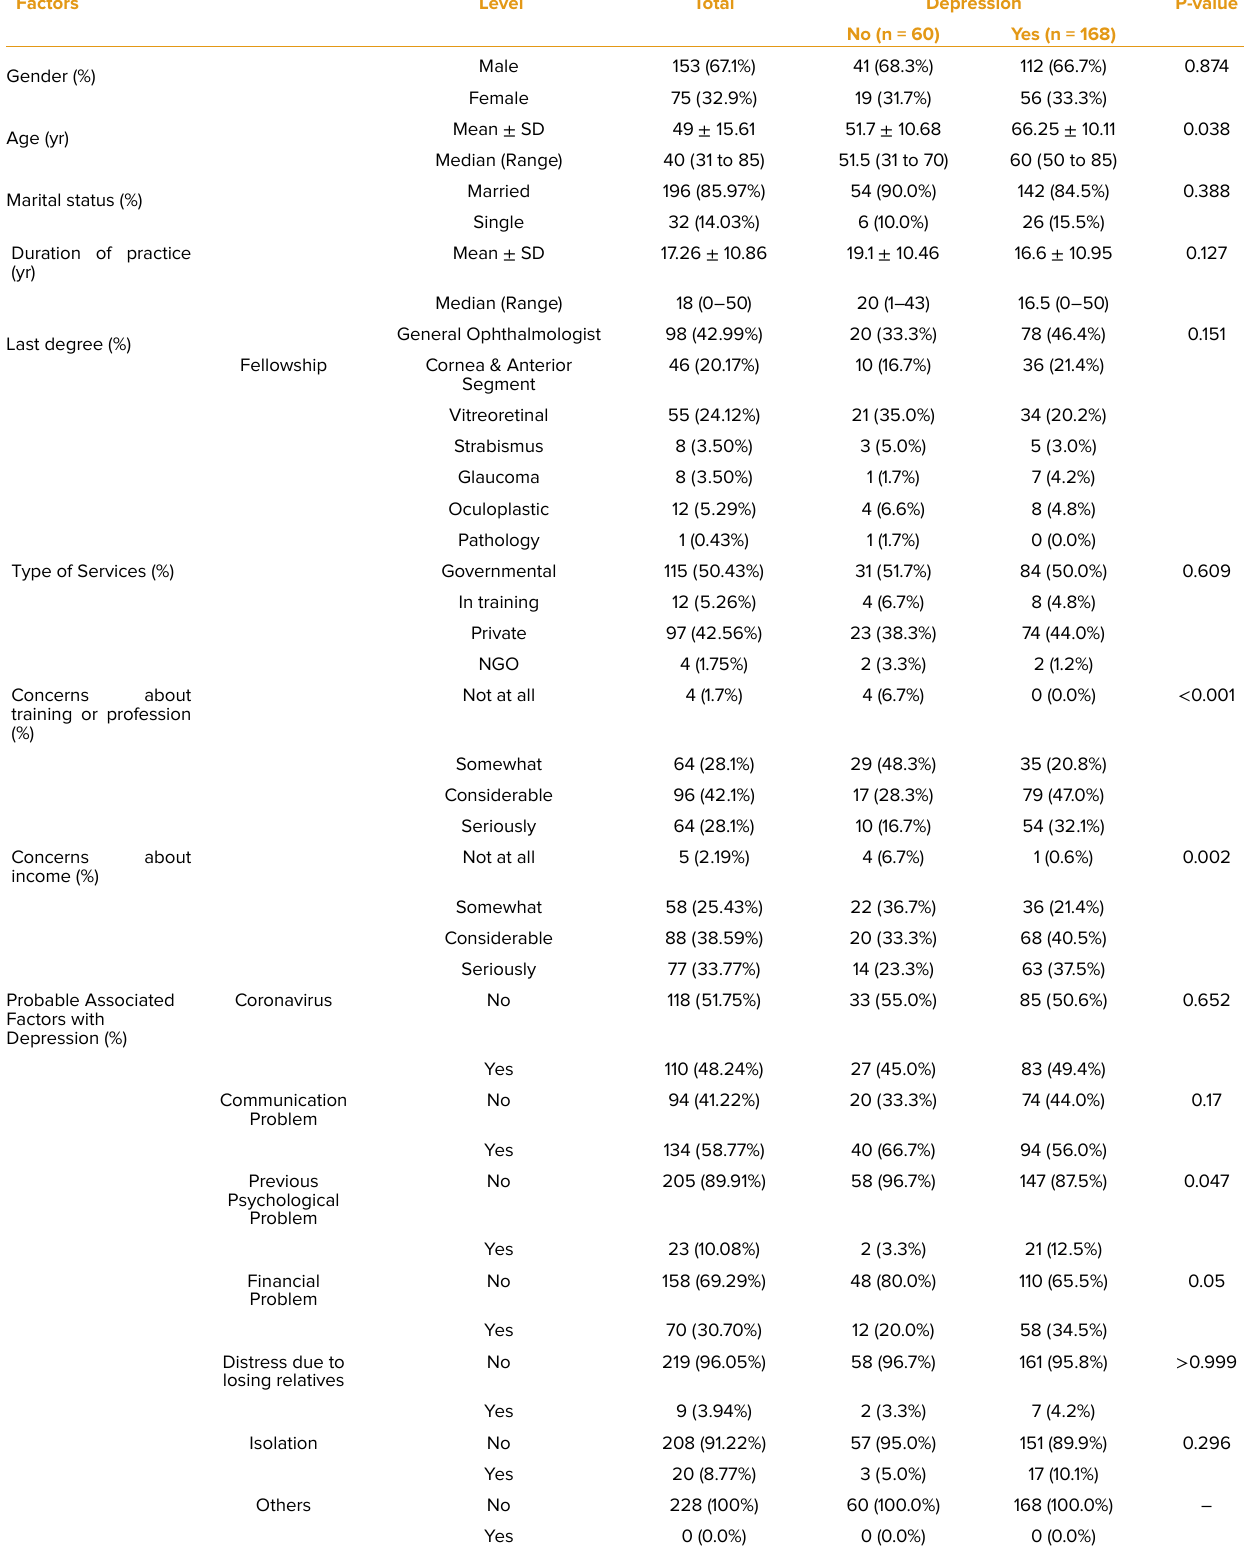
Table 1. Sociodemographic characteristics of the study population regarding depression